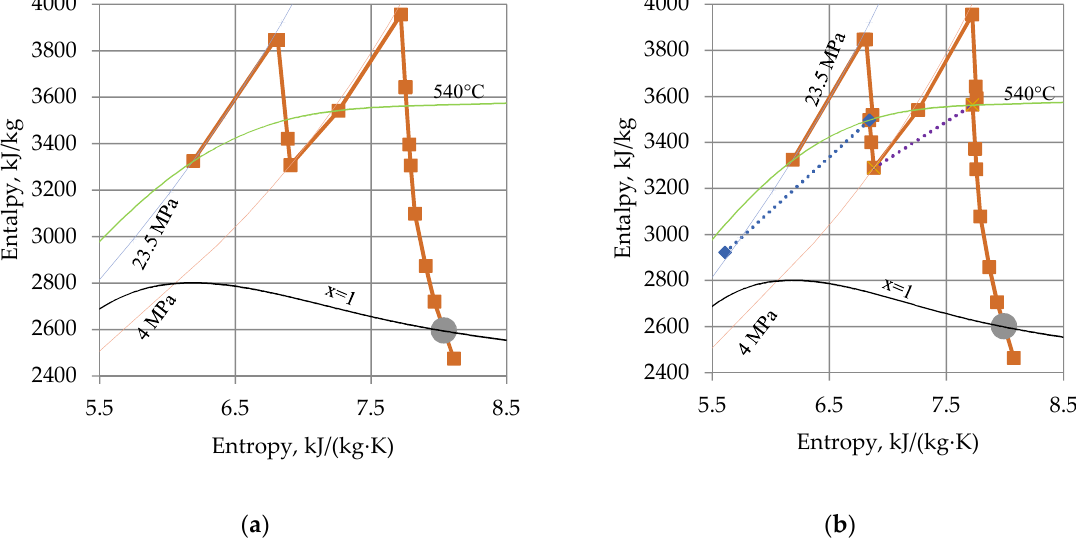
Figure 6. Steam heating in the HCC expansion in the steam turbine: ( a ) Uncooled turbine; ( b ) cooled turbine with 450 °C coolant temperature.